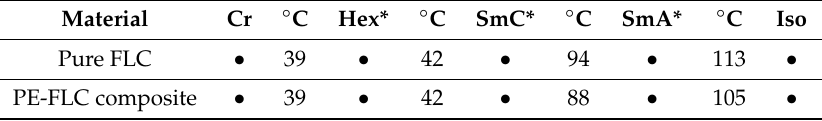
Table 1. Sequence of phases determined by POM and phase transition temperatures ( ◦ C)